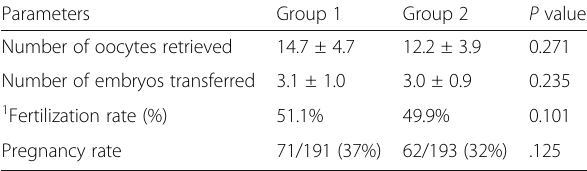
Table 4 Comparison between the frequencies of different forms of OHSS in both